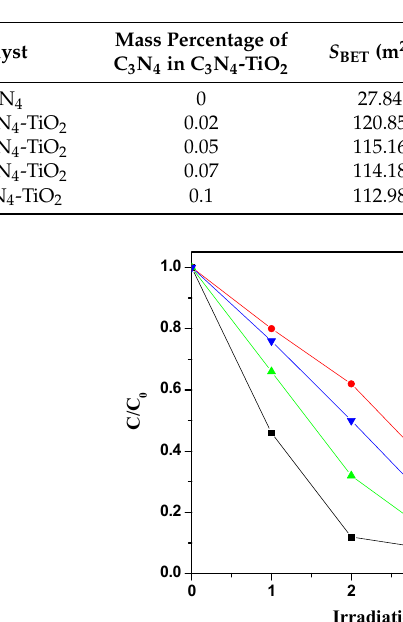
Table 1. Brunauer–Emmett–Teller specific surface area ( S BET , m 2 /g), absorption amount, and estimated pseudo-first-order kinetic constant ( k ) for the degradation of BDE209.